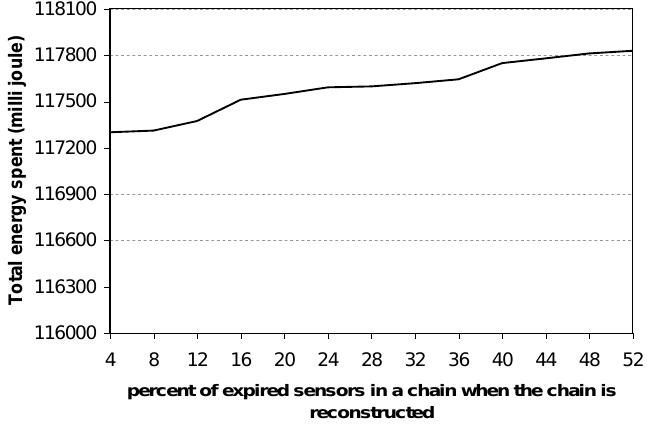
Figure 10. Total energy spent vs . percent of expired sensor nodes in a chain when the chain is reconstructed.